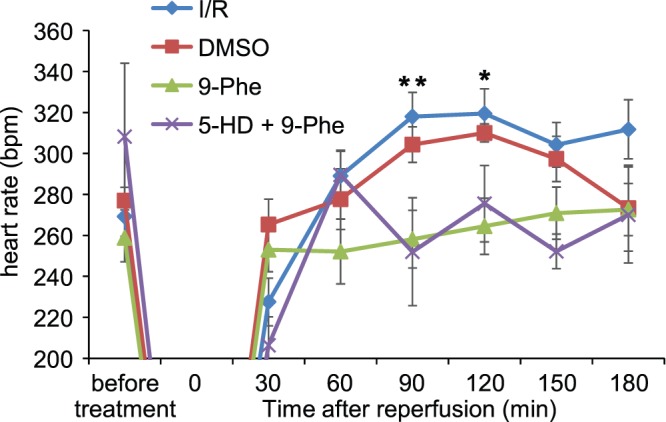
Measurement of heart rate.While heart rate increased after ischemia–reperfusion in the control group, that in 9-Phe-treated group was relatively stable. Simultaneous application of KATP channel inhibitor 5-HD did not affect the action of 9-Phe. Asterisks indicate a significant difference compared with the 9-Phe group as determined using Bonferroni post hoc tests.**p<0.01,*p<0.05.